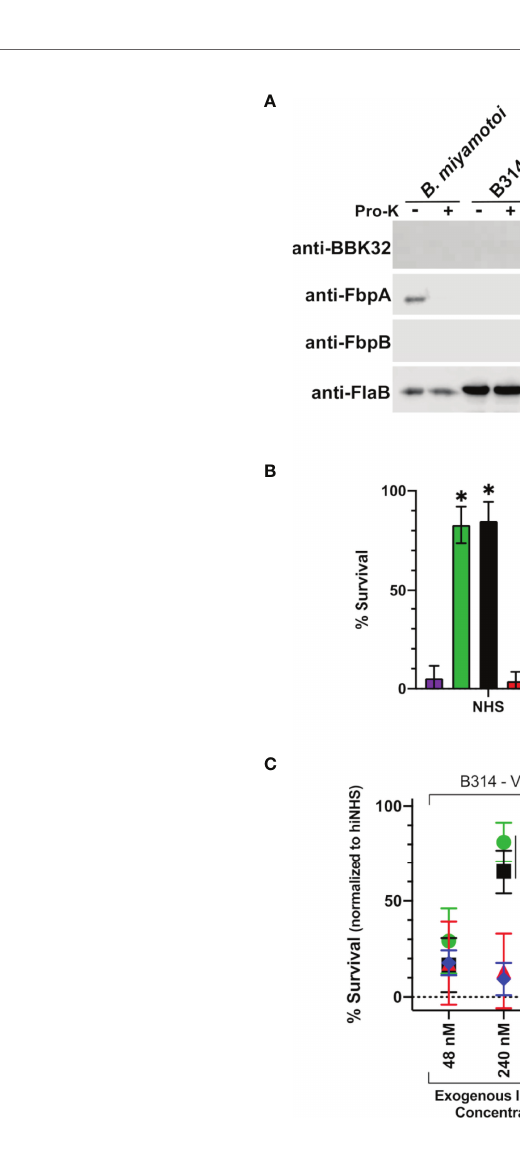
FIGURE 7 | Determining the ability of surface-expressed B. miyamotoi FbpA and FbpB to protect a serum-sensitive strain of B. burgdorferi . (A) Western blots of lysates from B. miyamotoi strain FR64b and B burgdorferi B314 isolates expressing fbpA , fbpA-DA , fbpB , and bbk32 were probed with antibodies to FbpA (anti- FbpA), FbpB (anti-FbpB), BBK32 (anti-BBK32) and FlaB (anti-FlaB), the latter as a loading control and a control for a subsurface target. Vector refers to the plasmid- only backbone sample (B314/pBBE22 luc ). Samples from each population were subjected to proteinase K accessibility treatments to determine the surface expression of the proteins. Due to its periplasmic location, the fl agellar protein, FlaB, is unaffected by proteinase K in intact cells and depicts structural integrity in the treated B. miyamotoi and B314 derivatives listed. (B) B. miyamotoi Fbp proteins were tested for their ability to confer resistance to normal human serum (NHS) sensitive B. burgdorferi strain B314 relative to vector-only and BBK32-expressing controls (negative and positive controls, respectively). Asterisks depict a signi fi cant increase in survival relative to FbpA DA and the vector control (*=p<0.0001). All strains exposed to heat inactivated NHS (hiNHS), rendering complement proteins inactive, were largely unaffected. (C) Rescue assays were used to determine if soluble exogenous recombinant proteins could promote survival of serum-sensitive vector-containing B. burgdorferi B314. Increasing fi ve-fold concentrations of BBK32-C, FbpA-C, FbpA DA-C, and FbpB-C were added in serum sensitivity assays. The middle samples (i.e., 240 nM) have added recombinant protein that is roughly equivalent to the concentration of C1r in the assay conditions employed. Cells were assessed via dark fi eld microscopy. Included as controls are a vector-only strain of B314 with no exogenous protein addition, as well as a BBK32-producing B314 isolate (right side). Asterisks depict a signi fi cant increase in survival relative to the vector control (*=p<0.015). Signi fi cance for serum sensitivity and rescue assays was determined using two-way ANOVA with a S ̌ ida ́ k correction for multiple